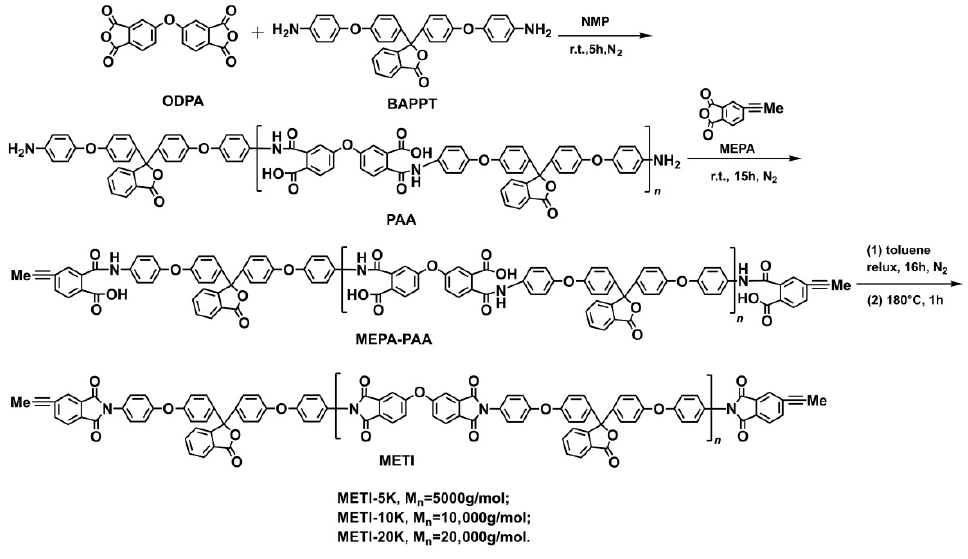
Figure 1. Preparation of METI resins.